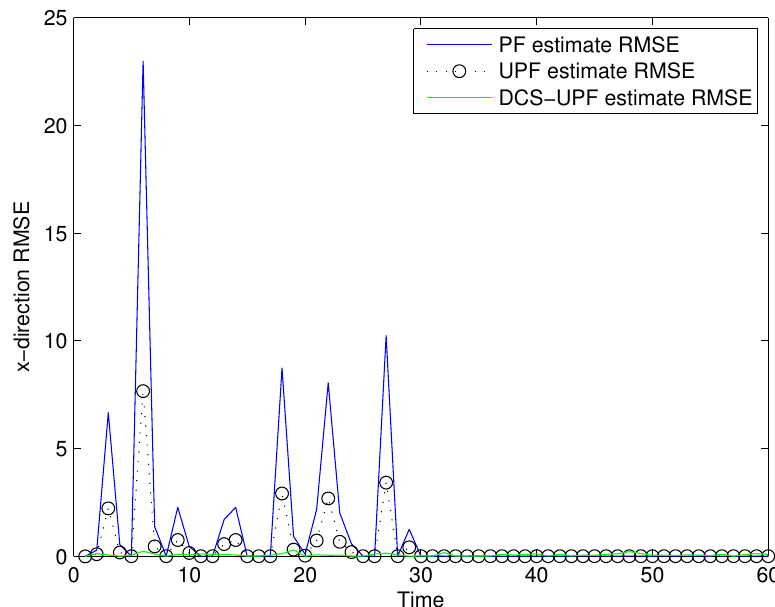
Figure 7. Target estimation in X-direction by changing R and Q.